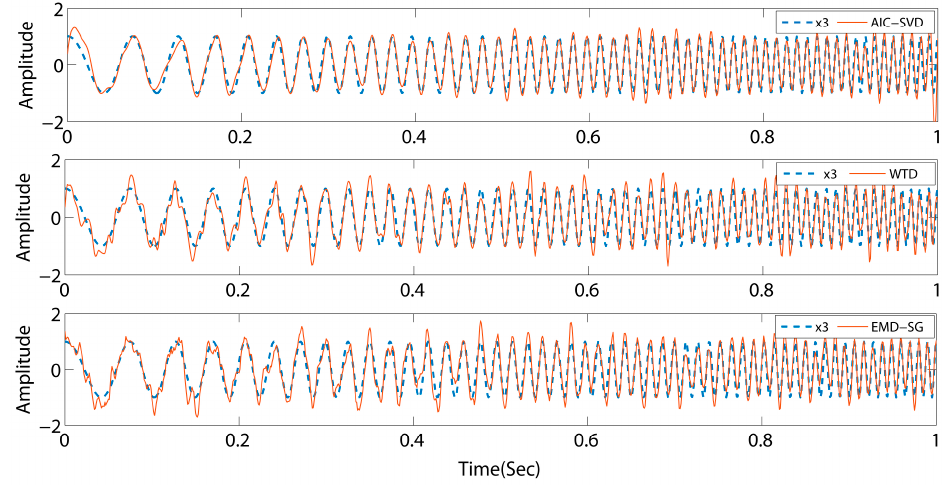
Figure 7. Comparison of denoising effects by different methods for signal 3 s .